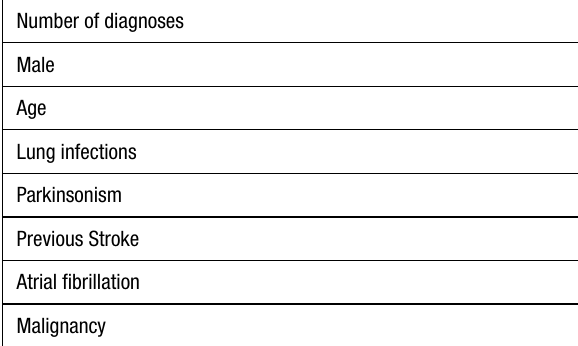
Table 4. Conditions associated with higher mortality among